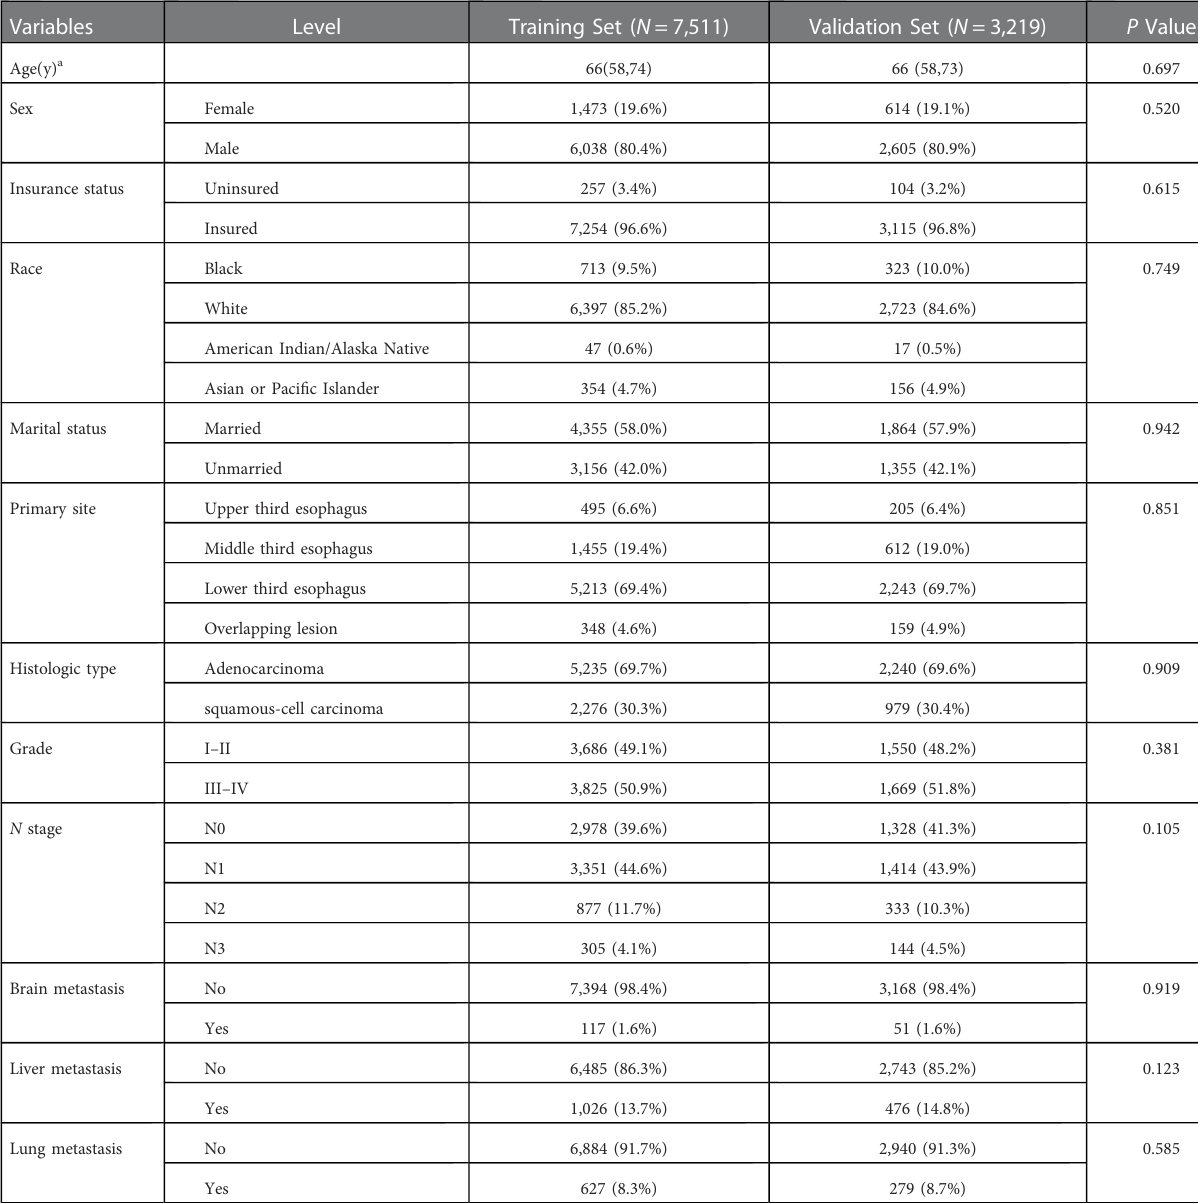
TABLE 2 Comparison of characteristics between training and validation groups in patients with esophageal